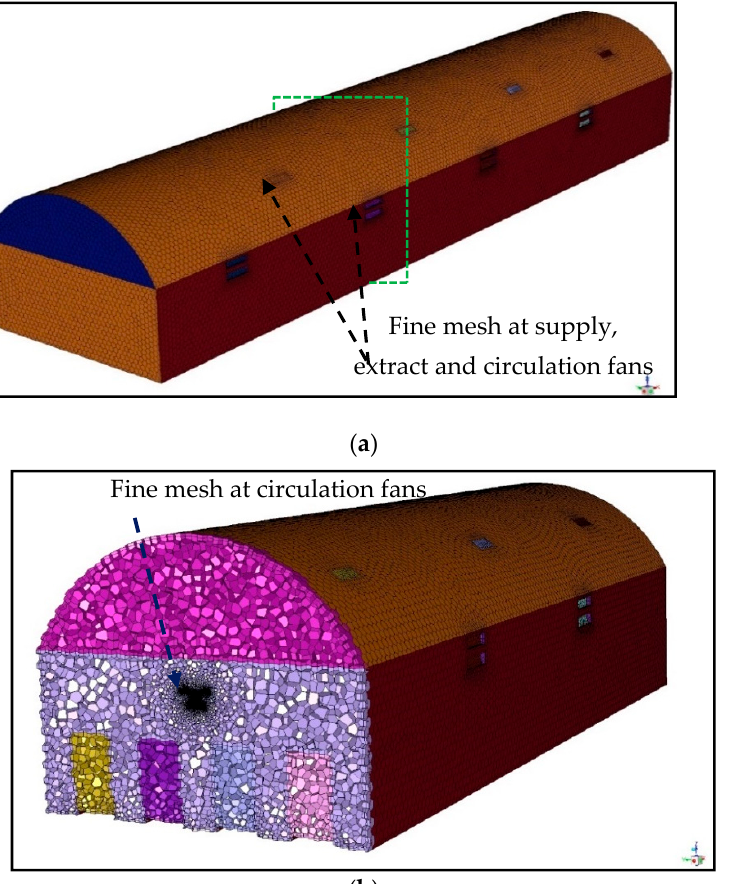
Figure 4. ( a ) 3D isometric view with 0.5 mm mesh and top cut view of the mesh. ( b ) 3D isometric cut view of 0.5 mm mesh of greenhouse.